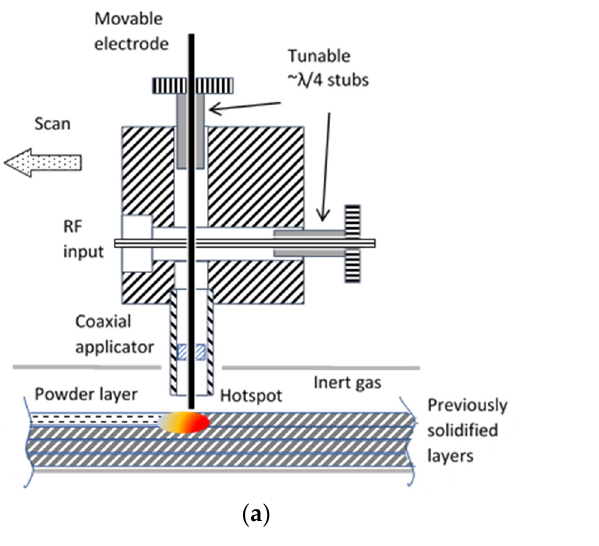
Figure 2. The scanning LMH–AM experimental setup: ( a ) A cross-section of the LMH applicator, including the integrated two-stub tuner and electrode feeder. ( b ) A block diagram of the peripheral equipment and the diagnostics employed in this experiment.